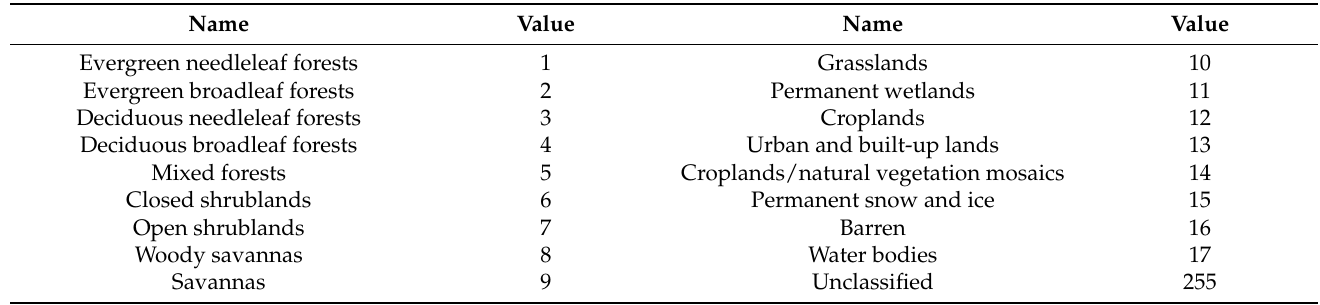
Table 1. Combined MODIS land cover type (MCD12C1) International Geosphere-Biosphere Pro- gramme